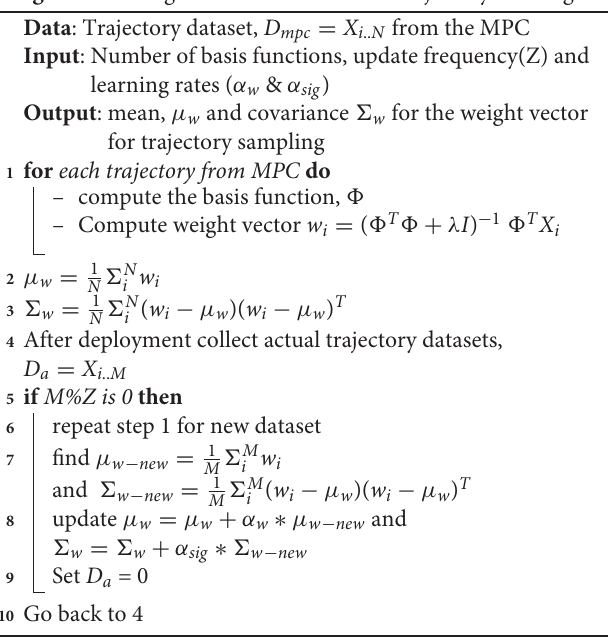
Algorithm 1: Algorithm for incremental trajectory